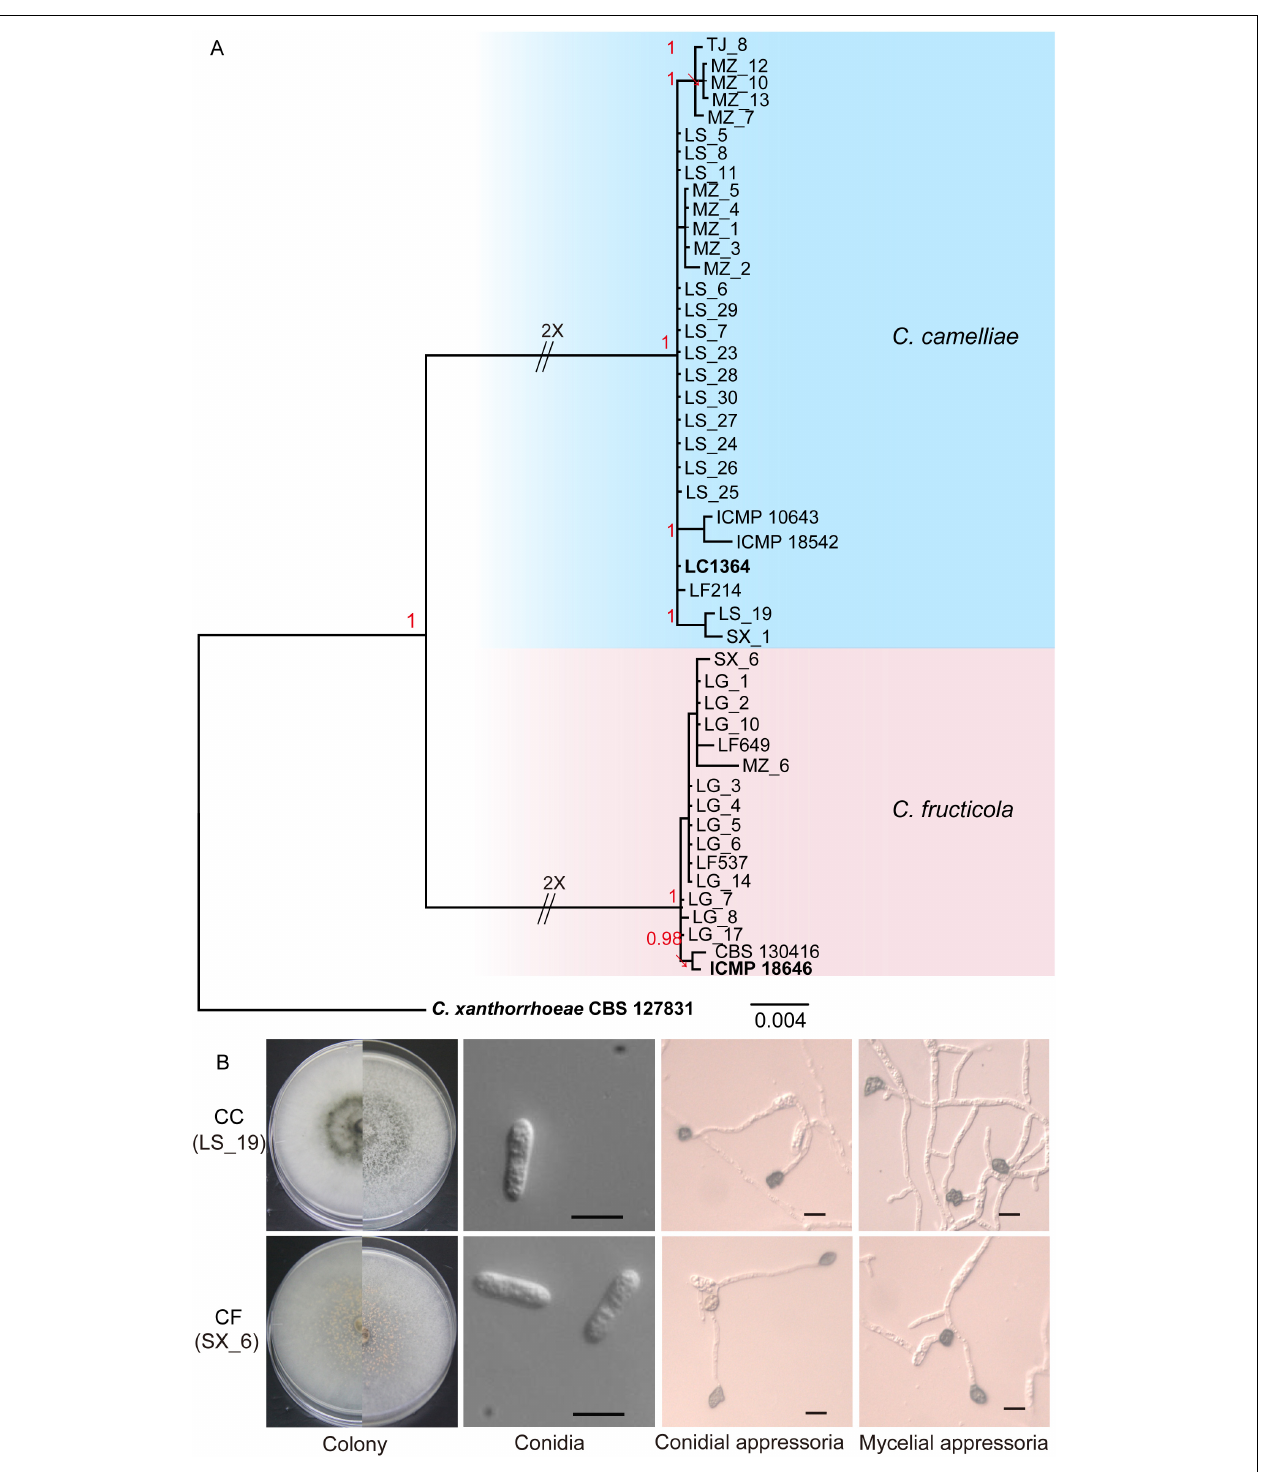
FIGURE 1 | Isolation and identification of Colletotrichum . (A) Phylogenetic tree generated by Bayesian analysis based on a 6-gene combined dataset (ITS, ACT, GAPDH, TUB2, CAL, and GS) showing the phylogenetic relationships of Colletotrichum isolates from Camellia sinensis . Bayesian posterior probabilities above 0.95 are shown at each node. C. xanthorrhoeae CBS 127831 was used as the outgroup. The scale bar indicates 0.004 expected changes per site. The branches crossed by diagonal lines are shortened by 50%. The ex-type strains are emphasized in bold: LG (Longguan), MZ (Maozhuyuan), and TJ (Tianjian) represent three different sampling points in Hangzhou. LS and SX represent Lishui and Shaoxin, respectively. (B) Morphological structures of C. camelliae (strain LS_19) and C. fructicola (strain SX_6). Scale bar = 10 µ